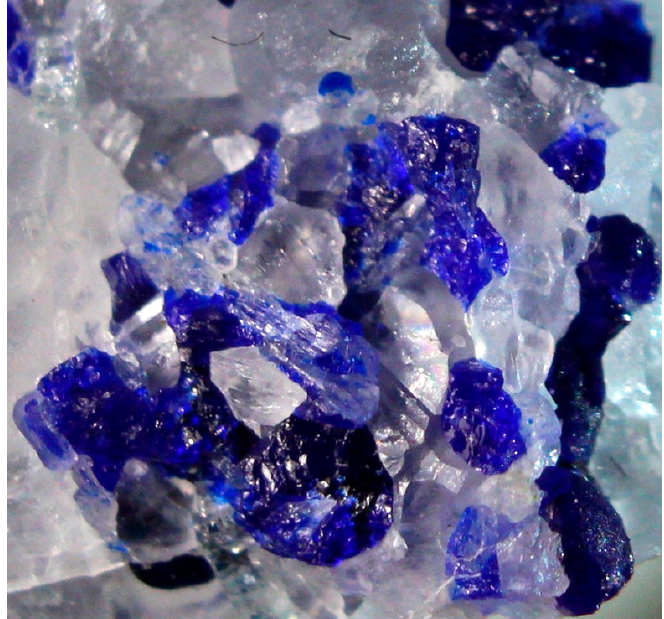
Figure 1. Grains of a deep blue sodalite-group mineral (the KL sample) in coarse-grained calcite. Field of view width: 6 mm. Photographer: Sergey V. Lipko.